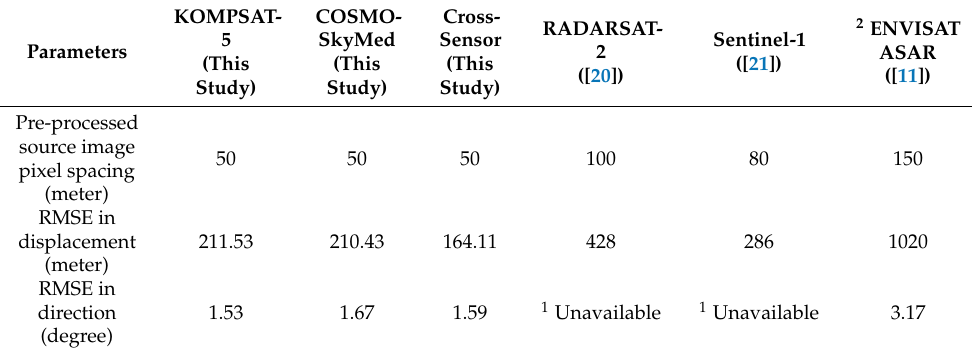
Table 5. Performance comparison to the previous